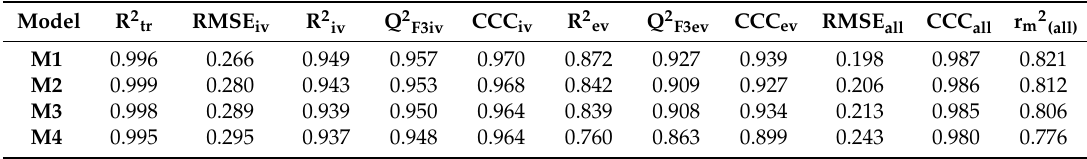
Table 4. Statistic parameters of the best four regression